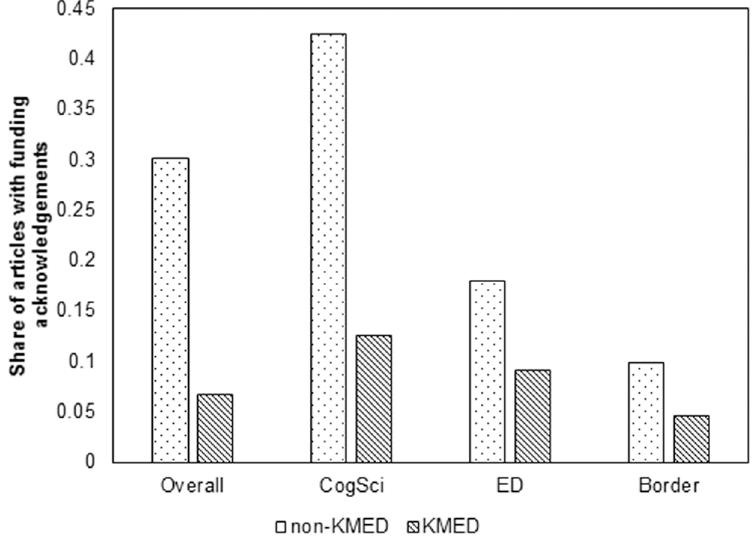
Fig 4. Comparison of share of the articles with funding Acknowledgement by (non-KMEDs vs. KMEDs).